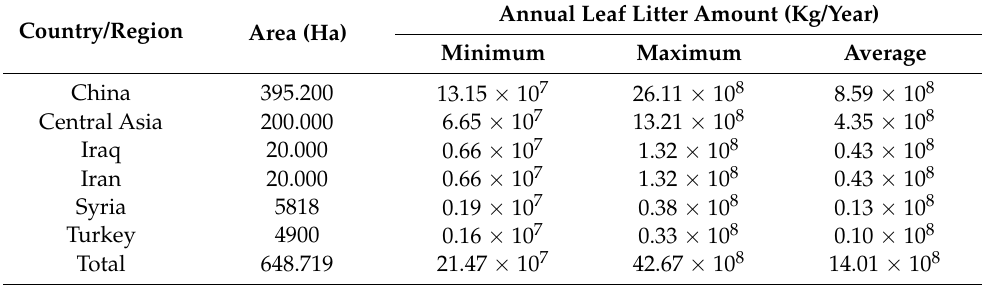
Source: Area data of P. euphratica forest adapted from Bai, 2010